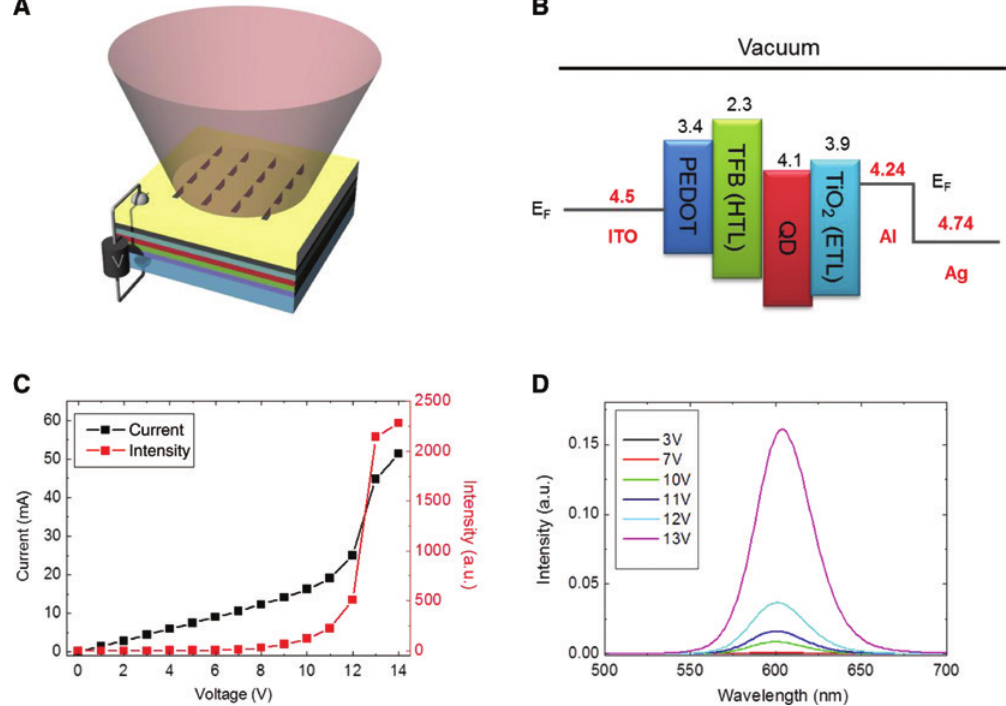
Figure 14: Integration of optical slot antennas with light emitting diodes. (A) Schematics of LEDs with antenna-integrated electrodes, (B) schematics of work functions in multilayered metal electrodes of LEDs, (C) current-voltage (black) and intensity-voltage (red) curves measured while increasing the voltage, and (D) EL spectra measured while increasing the